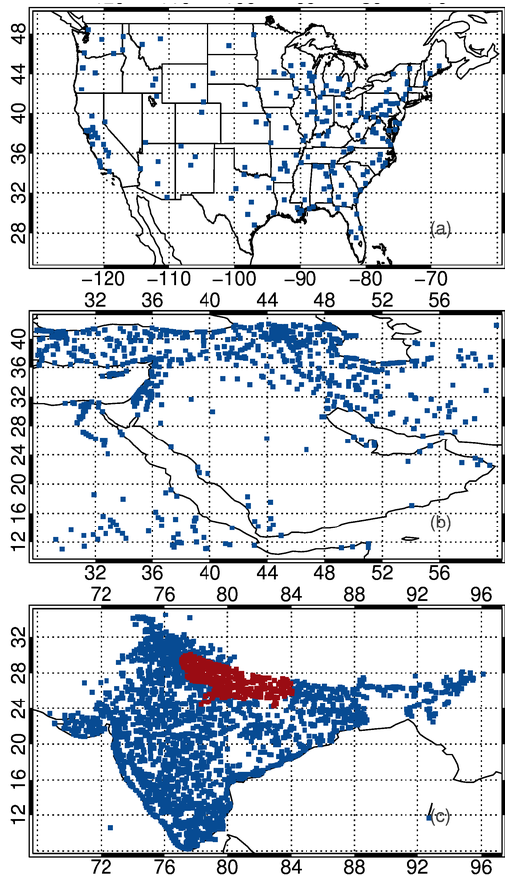
Figure 1. Spatial distribution of the (a) 200 cities over the US, (b) 999 cities over the Middle East and (c) 2995 cities over India used in this study. Red dots show cities and towns from the state of Uttar Pradesh (UP) in India – a region of climatologically high aerosol